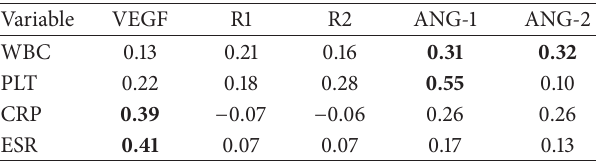
Table 3: Correlation between angiogenic proteins and laboratory parameters in JIA